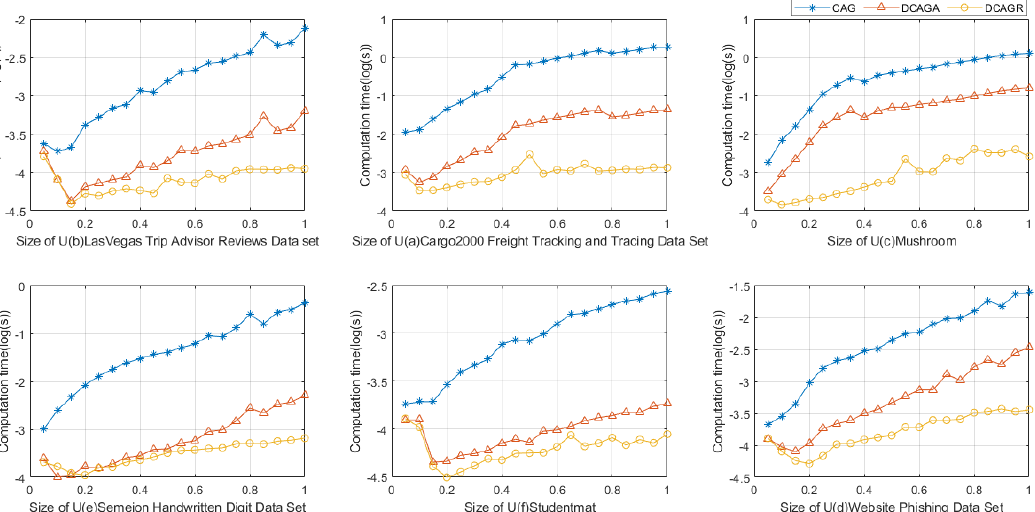
Figure 3. Comparison of the times of Algorithms 1 – 3 when the sizes of U increase gradually.